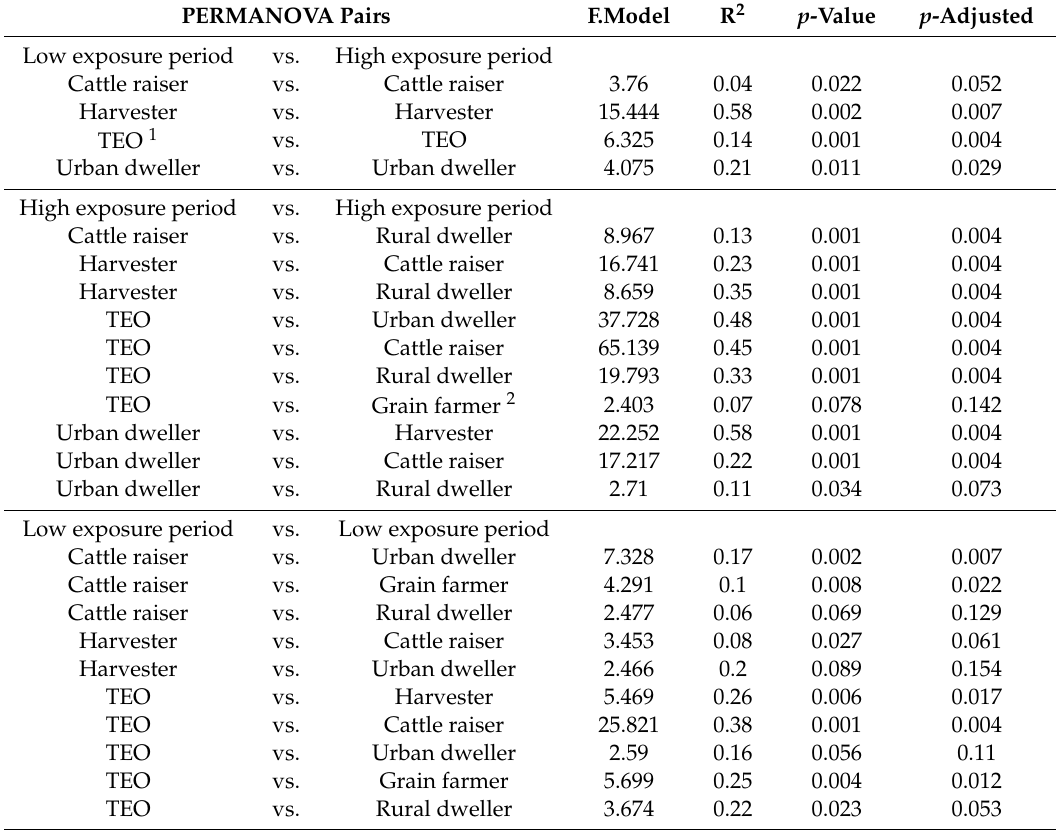
Table 2. Significant di ff erences in the fungal diversity as a function of the period of exposure to wheat dust among worker groups. Results of the pairwise PERMANOVA analysis